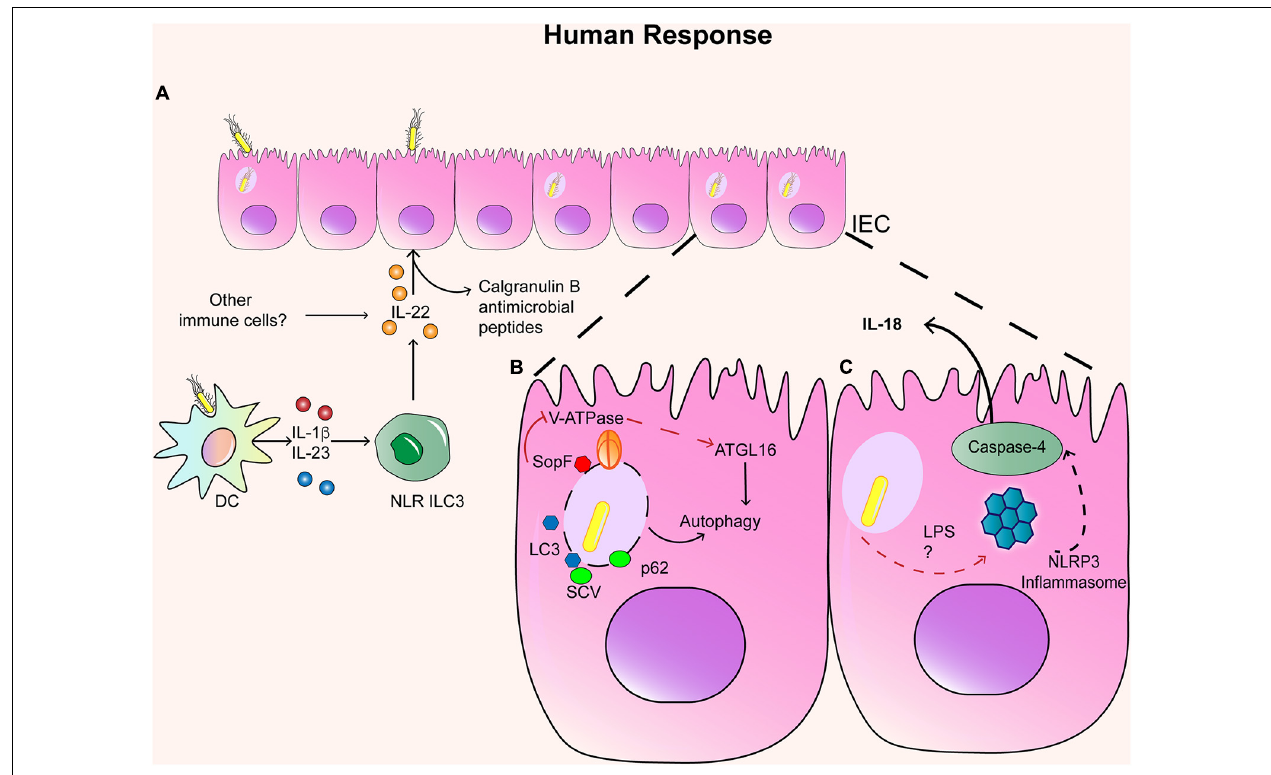
FIGURE 1 | Immune response in IECs. (A) Infected IEC respond to IL-22 secreted by NLR ILC3+ cells and other immune cells, which generate the production of Calgranulin B and other antimicrobial peptides. Infected IEC can also activate autophagy and inflammasome. (B) In the case of autophagy, SCV can colocalized with LC3 and p62 when the SCV is disrupted. However, SopF can block the interaction between ATGL16 and the SCV, inhibiting autophagia. (C) In the case of the activation of the inflammasome, LPS and TTSS-1 can activate NLRP3 inflammasome and the caspase 4 and secretion of